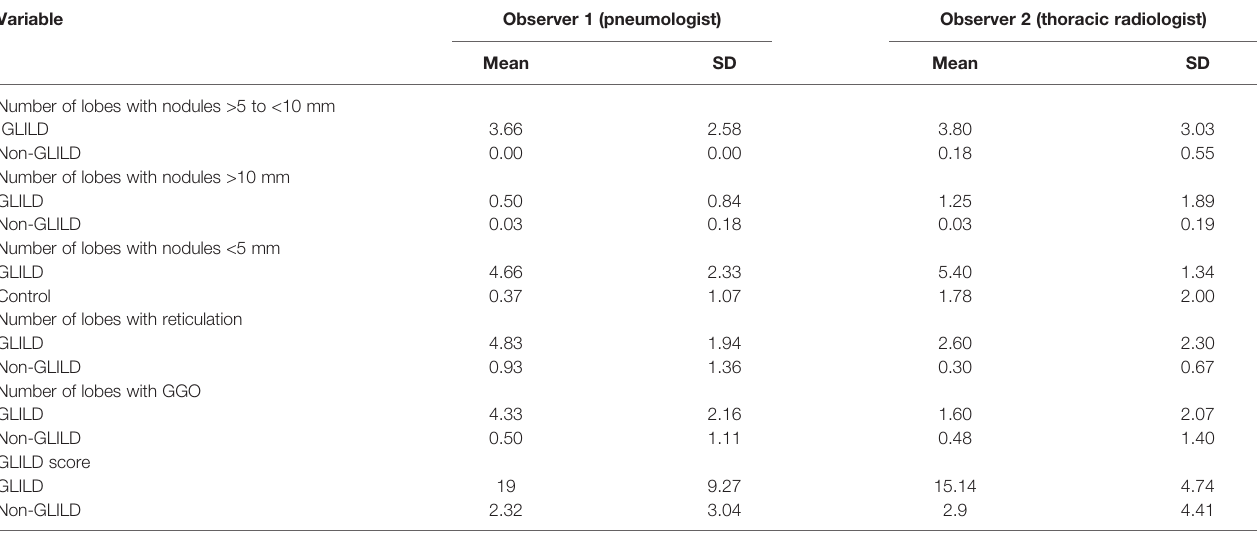
TABLE 4 | Differences in the observers ’ fi ndings of variables included in Baumann ’ s composite score: nodules, reticulation, and ground-glass opacities, and composite GLILD score. Variable Observer 1